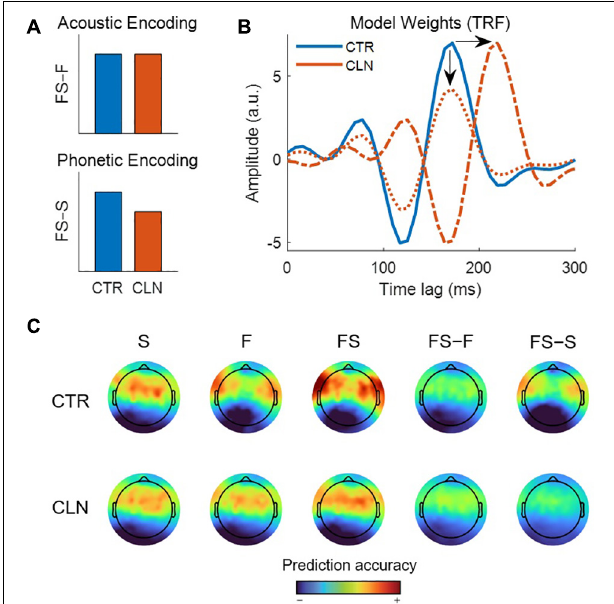
FIGURE 3 | Hypothetical results for example experiment using forward models. (A) We hypothesize that there is a deficit in the neural processing of phonetic features in a clinical group (CLN, red) relative to our control group (CTR, blue). We obtain a measure of acoustic encoding by quantifying the differential in prediction scores (e.g., correlation coefficient) between the combined spectrogram + phonetic features model (FS) and the individual phonetic features model (F). Similarly, we obtain a measure of phonetic encoding by quantifying the differential in prediction scores between FS and the individual spectrogram model (S). We would expect to see no group effect in acoustic encoding, whereas for phonetic encoding, we would expect to see reduced performance in the clinical group, indicative of a deficit in phonological encoding. (B) Hypothetical group differences in average phoneme TRF weights. The group average TRF for control subjects is shown as the blue trace. One possible scenario shows a reduction in TRF amplitude for the clinical group (red dotted trace), which could indicate either reduced neural activity or increased inter-subject variability. Alternatively, there could be a difference in TRF latency (red dashed trace), due to delayed neural processing. (C) Hypothetical scalp topographies of forward model prediction scores for control and clinical groups. These hypothetical results depict differences in prediction score, as per our hypothesis, but also differences in the distributions of those scores across the